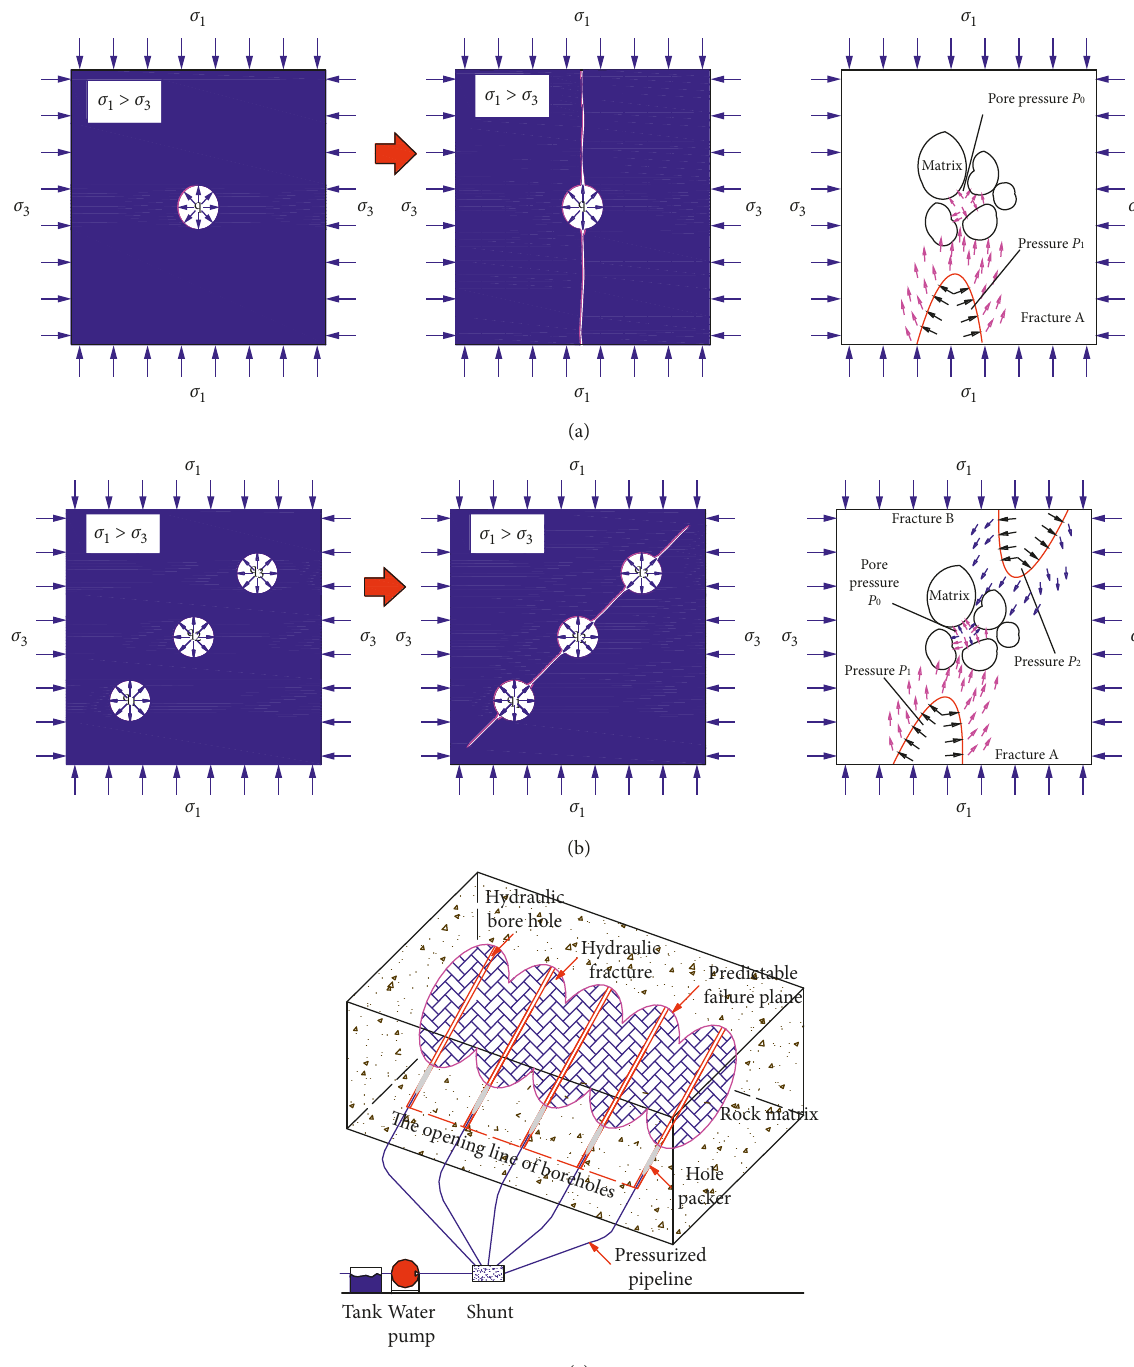
Figure 1: Principle and technology of directional hydraulic fracturing controlled by dense linear multihole drilling. (a) Traditional principle of directional hydraulic fracturing. (b) Principle of directional hydraulic fracturing controlled by dense linear multihole drilling. (c) Technology of directional hydraulic fracturing controlled by dense linear multihole